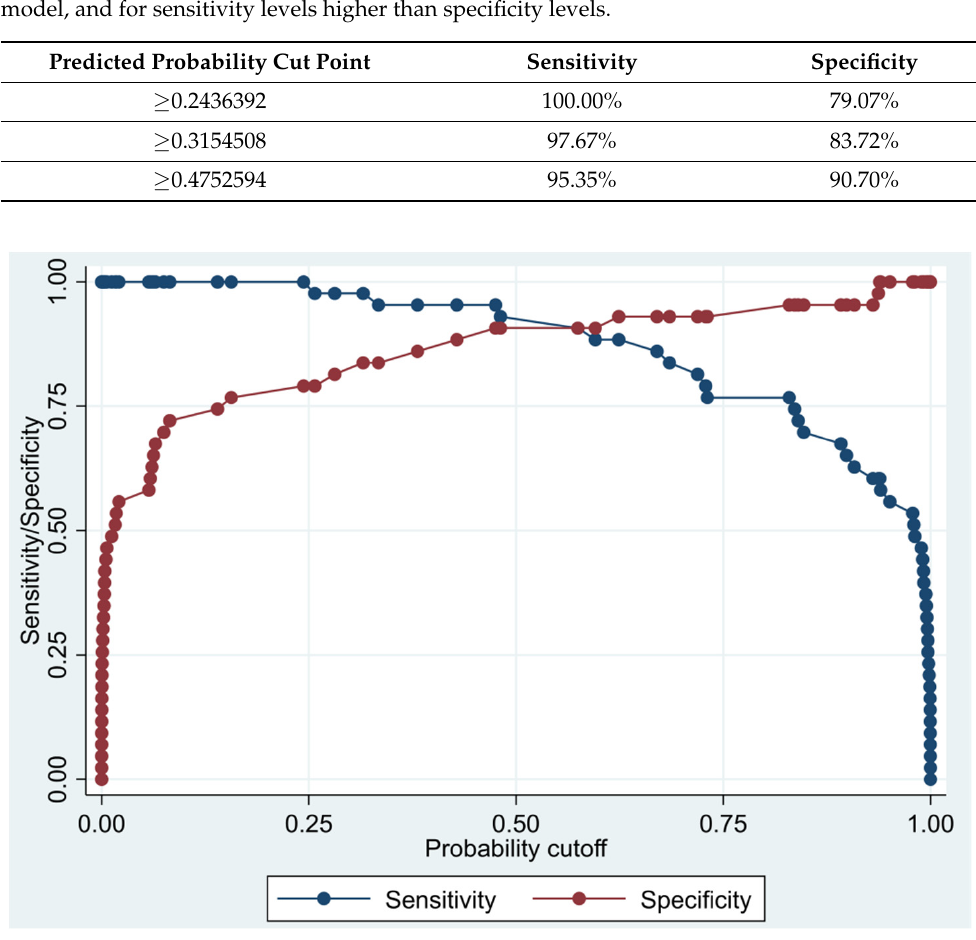
Figure 5. Sensitivity and specificity plot of the final multivariate logistic regression model based on cytokines resulting from the two final models based on both the immune-oncology and the oncology panel.